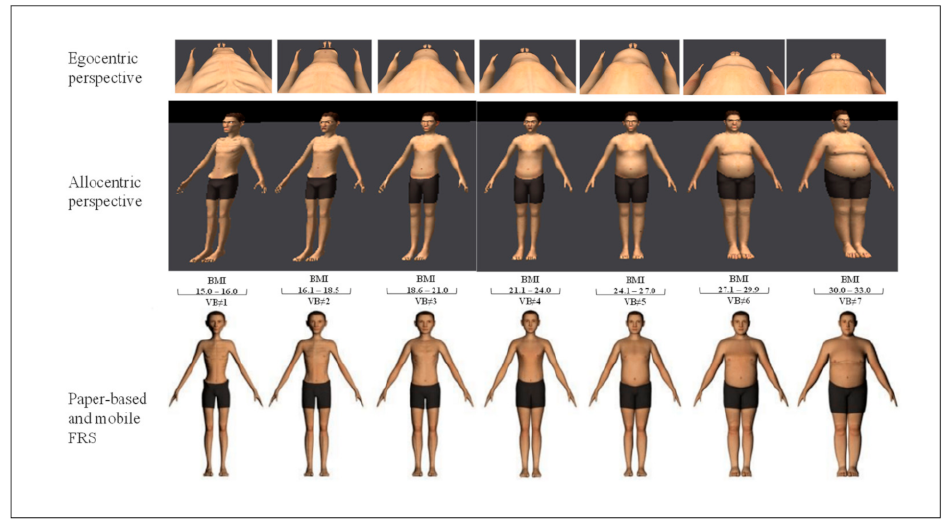
Figure 2. Representation of the allocentric and egocentric perspectives of e LoriCorps-IBRS 1.1 used with male